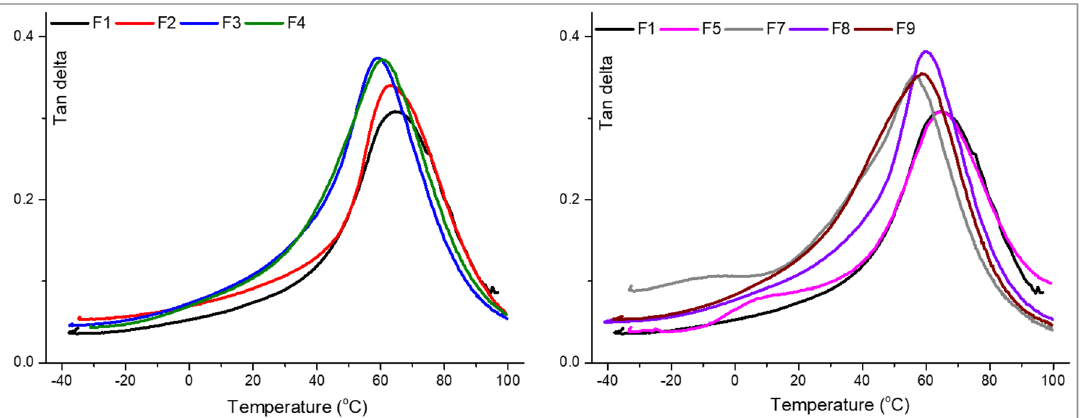
Figure 7. DMA curves (Tan delta vs. temperature) recorder for selected ELALO-based materials. Influence of the SDA—left graph and influence of both additives—right graph.